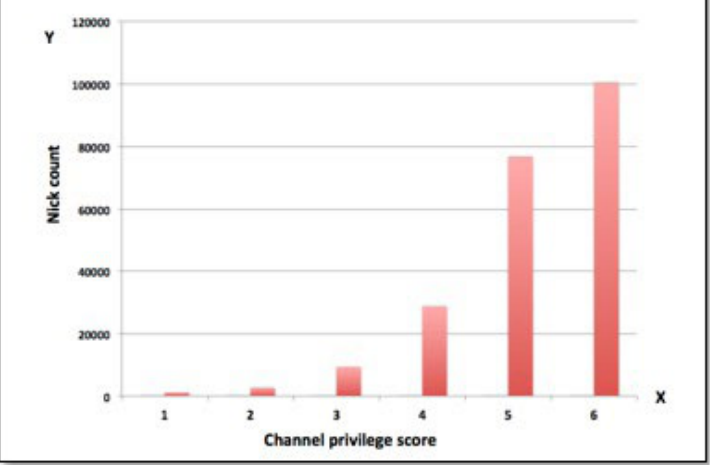
Figure 5: nick to privilege